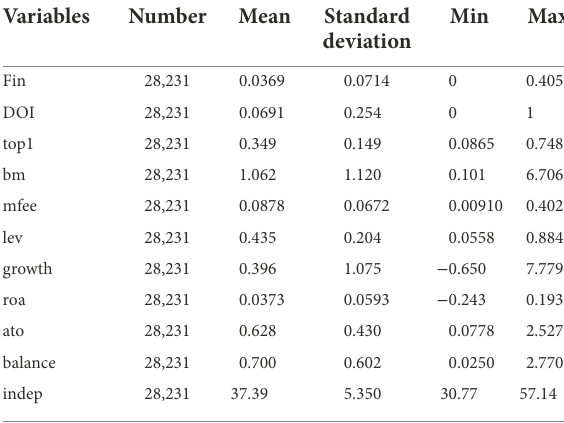
TABLE 3 The results of correlation